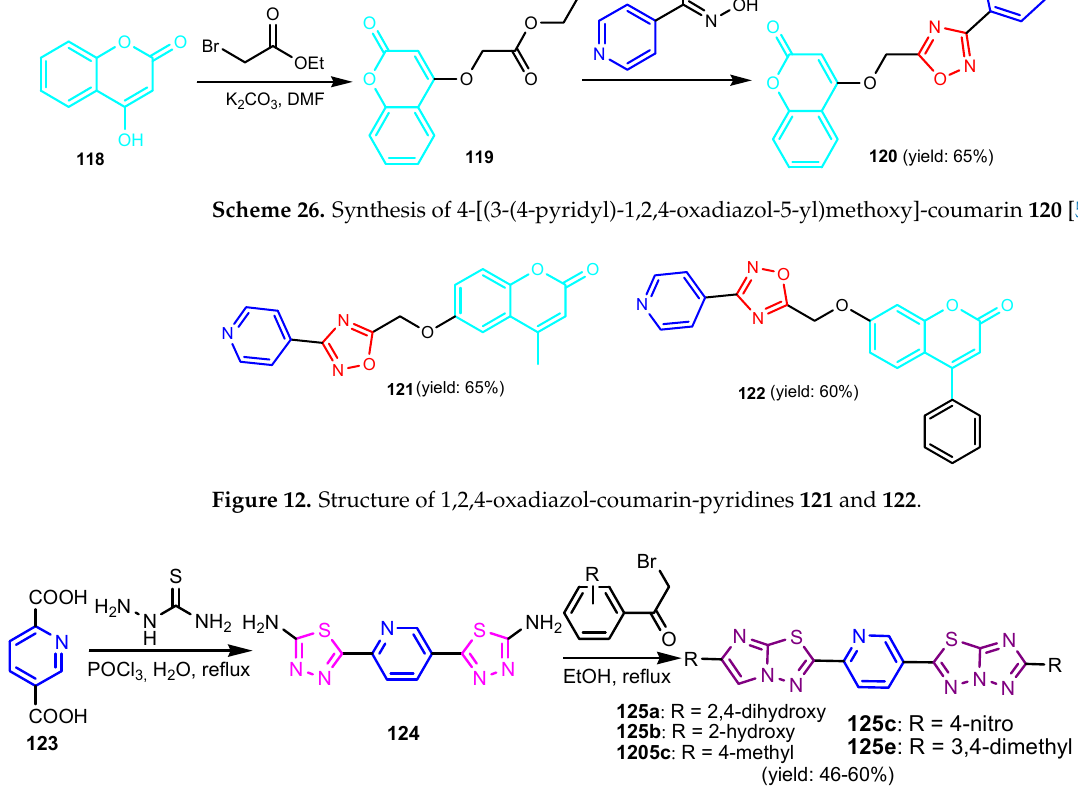
Scheme 28. Synthesis of pyridine-triazoles 127a − 127k [57]. NAr OAc OAc OAc 130 (yield: 91%) Figure 13. Structures of compounds 128 − 132 [58]. Table 6. Antimicrobial activity (MIC values in µg mL − 1 ) of pyridine triazoles 122a − 122k [57]. Compd.